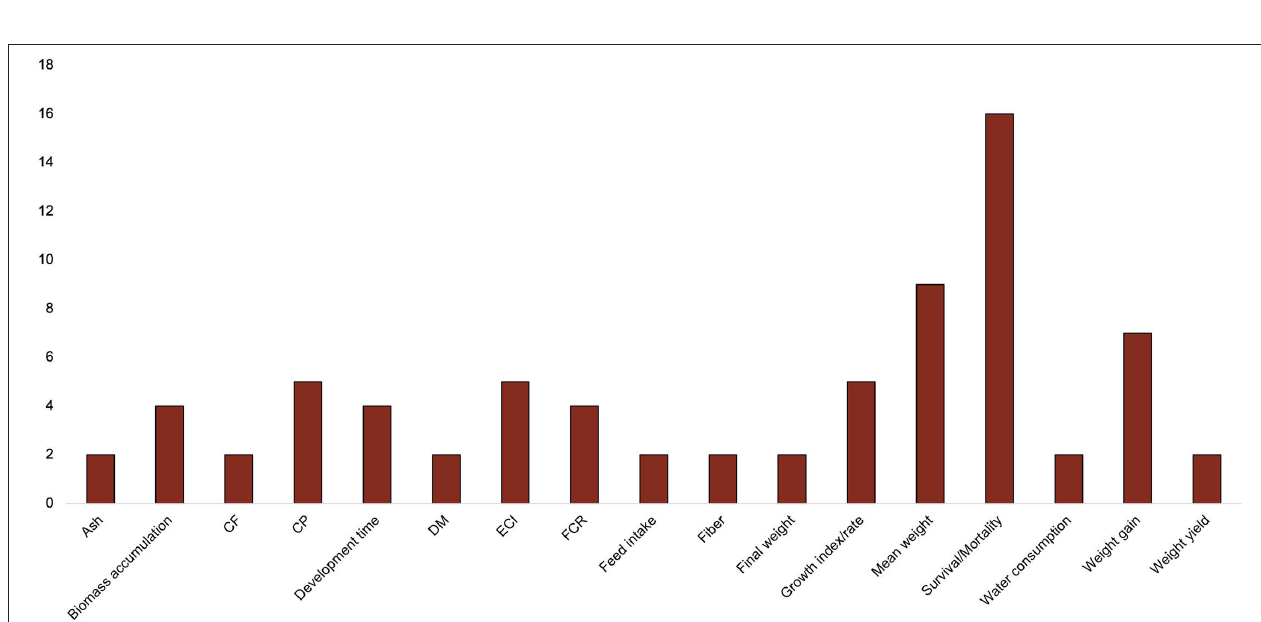
FIGURE 5 | Frequency of insect measurements across studies. CF, crude fiber; CP, crude protein, DM, dry matter; ECI, efficiency conversion of ingested food; FCR, feed conversion ratio.